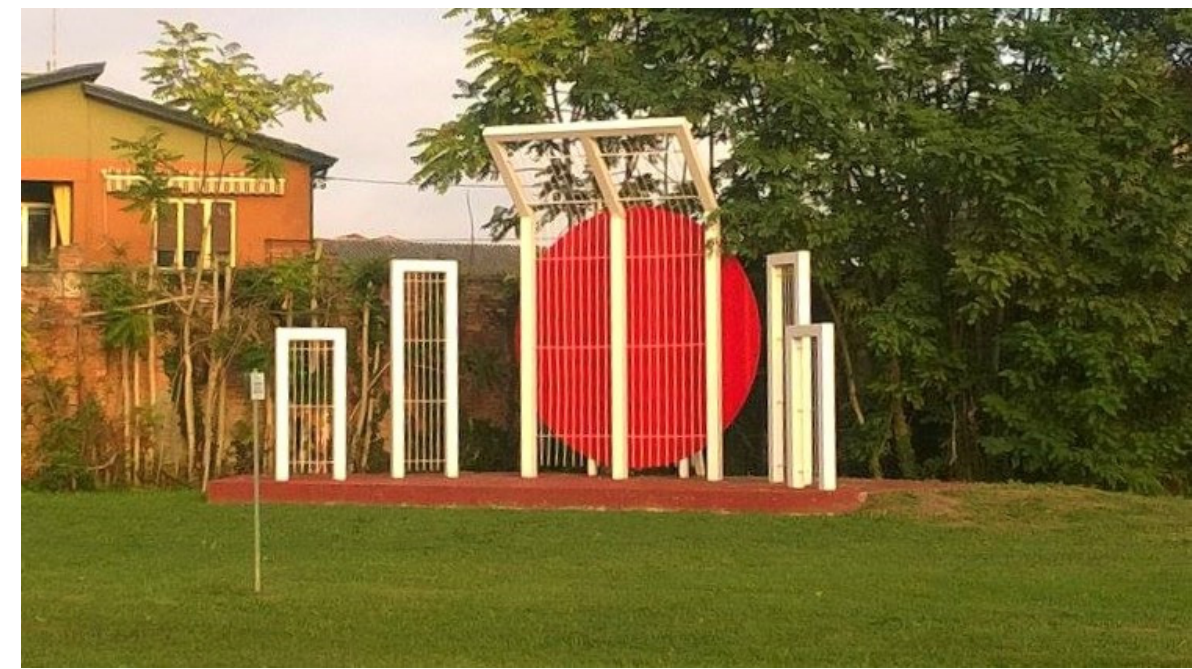
Figure 1. The Bangladeshi Shahid Minar monument at Breda Park in Cardonygye in the Province of Padova. Source: Fieldwork (2018).